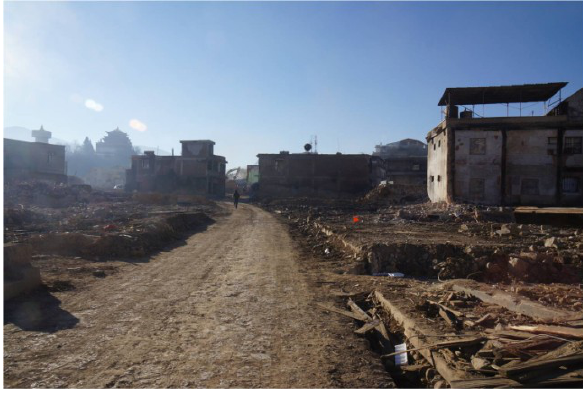
Figure 3. North Gate Street After the Fire Photo: Dr. Ing. HUO Xiaowei